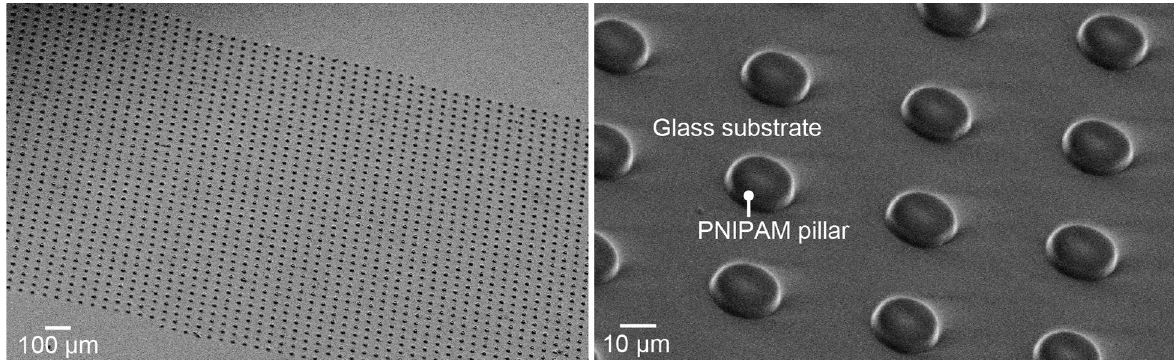
Figure 3. Scanning electron microscopic images of the PNIPAM pillars on a glass